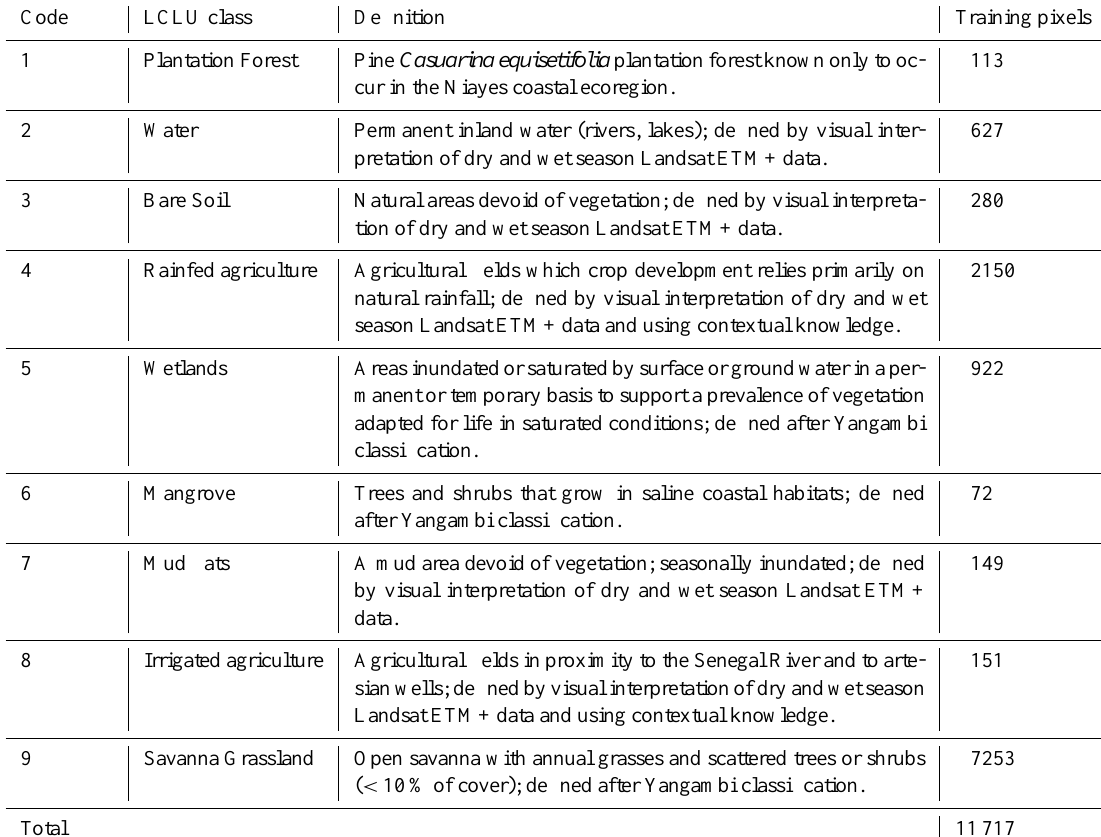
Table 2. Description of the 9 land cover land use (LCLU) classes and the number of training pixels used for the